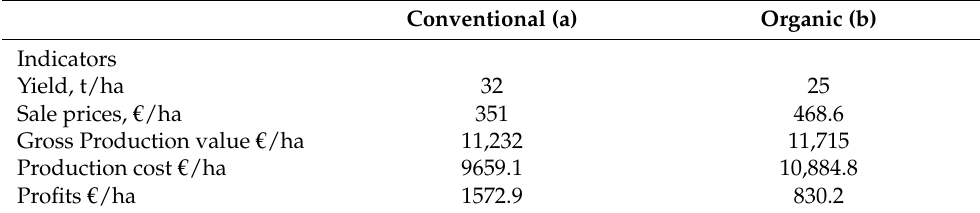
Table 8. Economic values of early potato growing